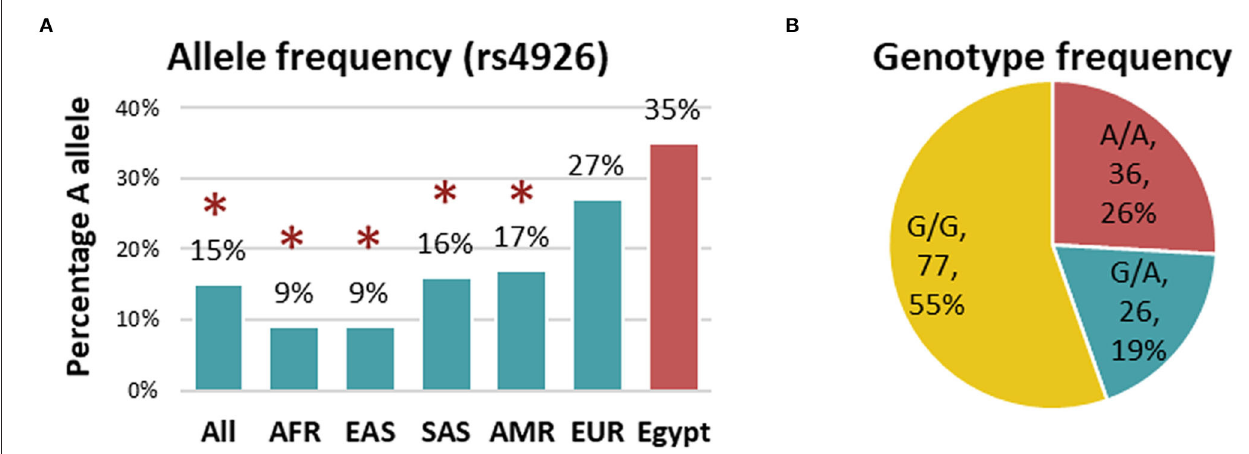
FIGURE 1 | Genotype and allele frequency of C1INH rs4926 polymorphism in the studied population. (A) Allele frequency of rs4926 G/A polymorphism in the current study (red) compared to other populations (green) reported in 1000 Genome Project. AFR, African; EAS, East Asian; SAS, South Asian; AMR, American; EUR, European. A two-sided Chi-square test was used. [Data source: ensembl.org]. (B) Genotype frequency of rs4926 (c.1438G > A) across the whole cohorts. *Indicates the p-value < 0.05.